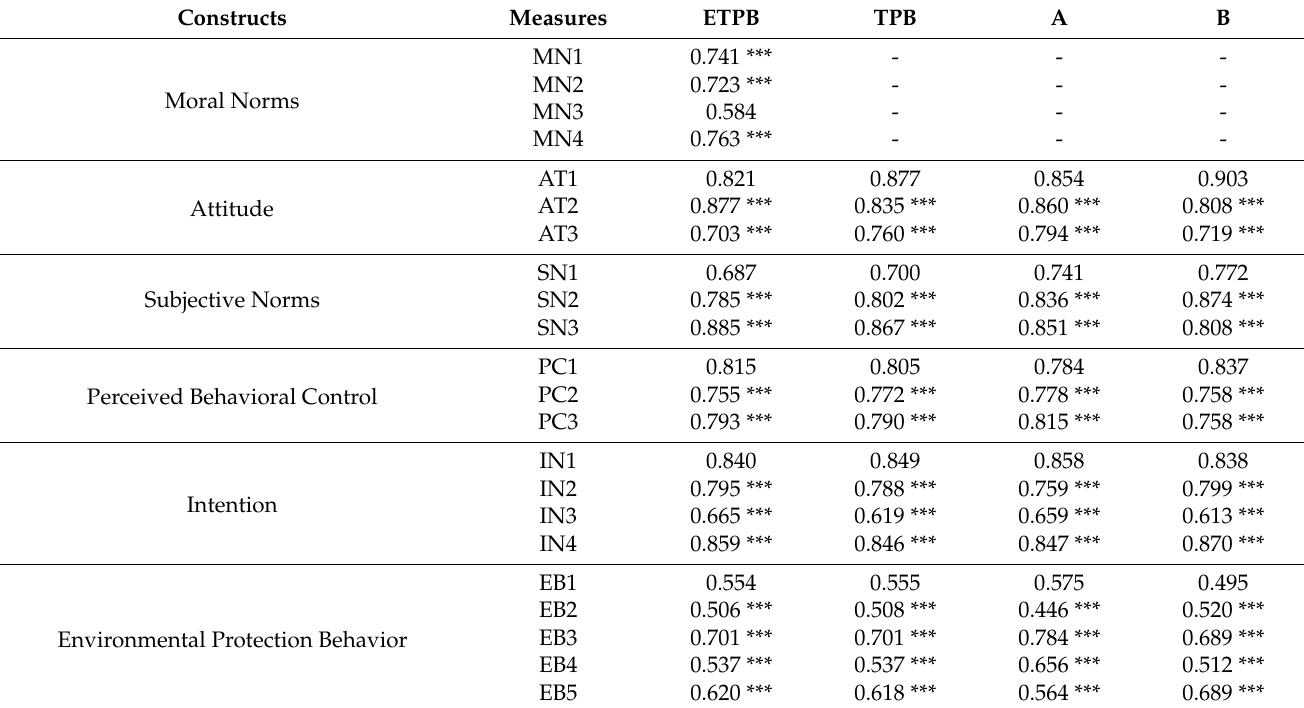
Table 6. SEM standardized regression coefficients for various